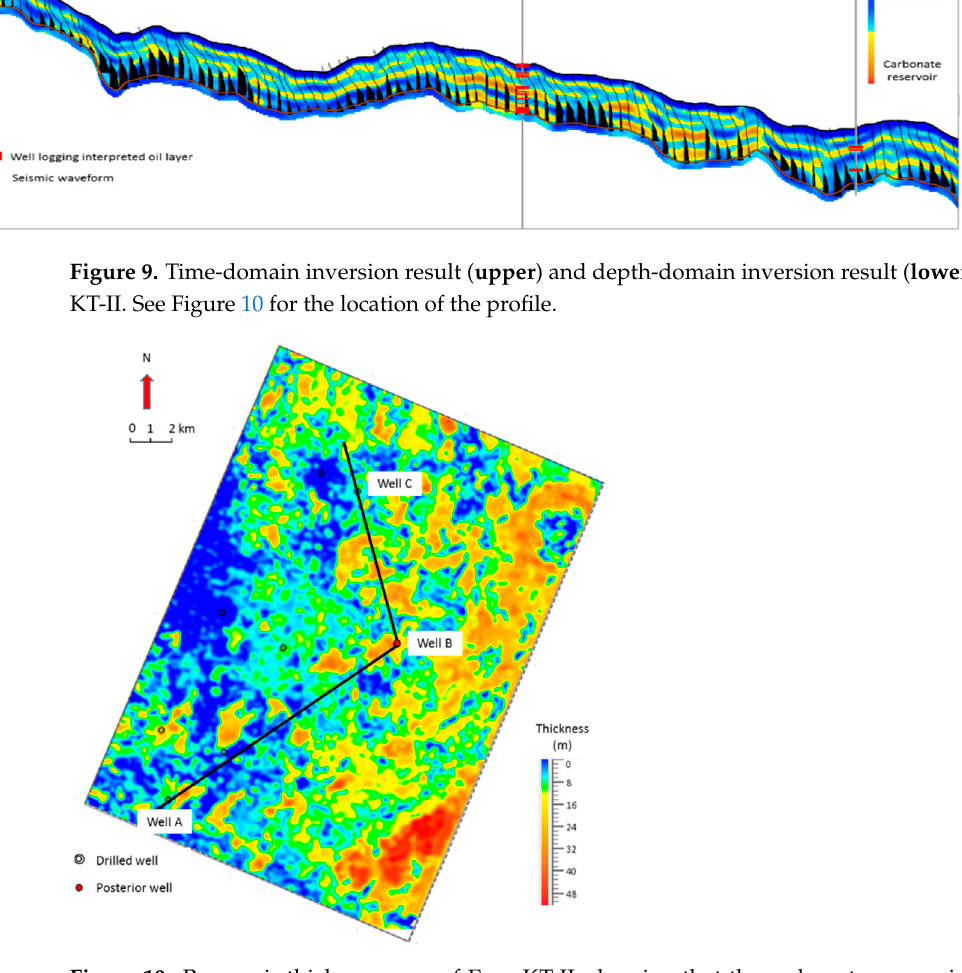
Figure 10. Reservoir thickness map of Г 1–2 , KT-II, showing that the carbonate reservoir is much developed in the eastern region of the study area.